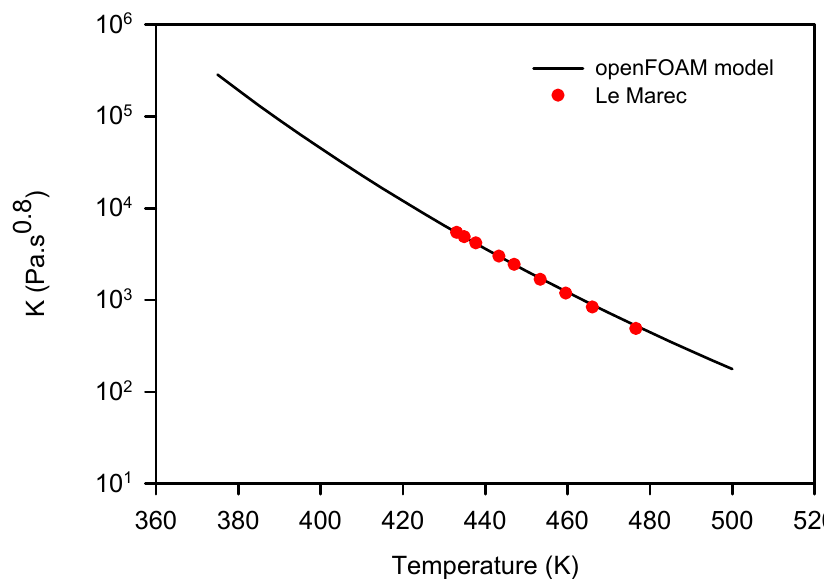
Figure 3. K vs. T by fitting the experimental data from Le Marec et al. [25] to Equation (4).